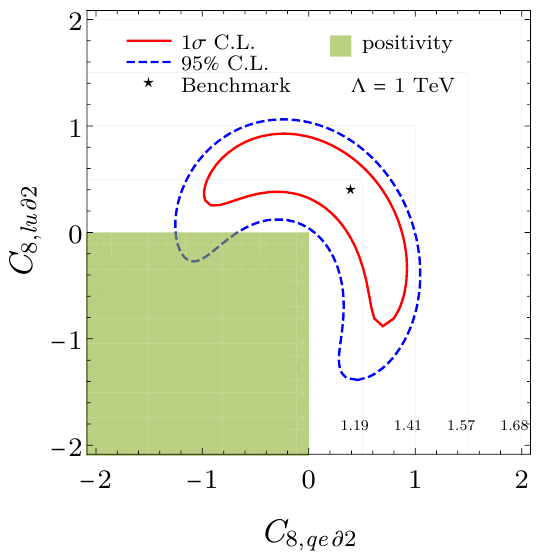
Figure 5 . A benchmark case of positivity violation in the 2D subspace ( C 8 ,qe∂ 2 , C 8 ,lu∂ 2 ) in the presence of experimental uncertainties. The green region is where the elastic positivity bounds are satisfied. The grey solid lines are the values of ∆ − 1 . We set Λ = 1 TeV in this